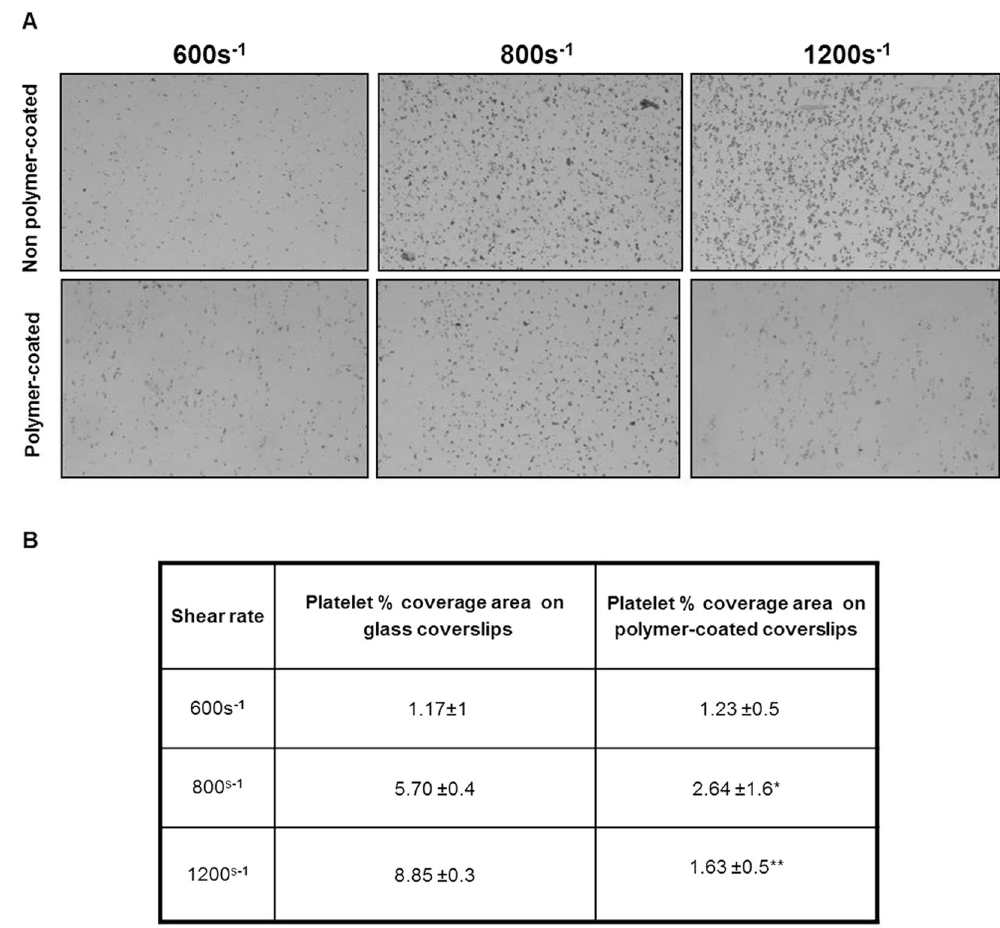
Figure 2. Platelet surface coverage on non polymer-coated and polymer-coated coverslips. Citrated blood samples were perfused through a parallel-plate perfusion chamber containing uncoated and polymer- coated coverslips at a shear rate of 600 s − 1 , 800 s − 1 and 1200 s − 1 . ( A ) Representative images of phase contrast microscopy showing platelet surface coverage (magnification; x10). ( B ) Percentage of platelet surface coverage area under the different flow conditions. Data from 2 independent experiments performed in triplicate are expressed as mean ± SD ( * P < 0.05), ( ** p <